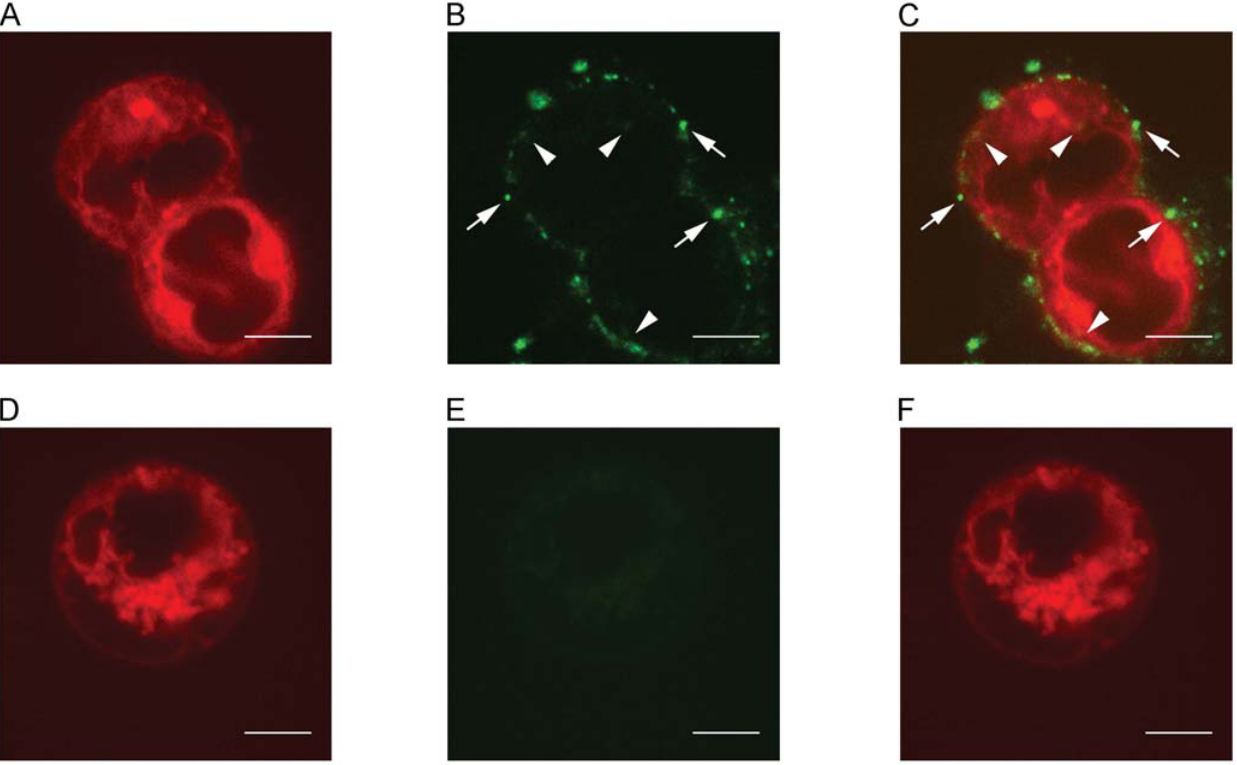
Figure 6. ESMVs transfer GFP. ESCs without the GFP transgene were labeled with DiD and then incubated with ESMVs containing GFP. All confocal images were taken using a 100 6 , 1.4 NA objective with the pinhole set to 1 airy unit. (A) DiD signal from ESCs incubated with ESMVs. (B) GFP signal from ESCs incubated with ESMVs. Arrows indicate punctate signal, likely representing docked vesicles. Arrowheads indicate diffuse signal, likely from the diffusion of GFP inside the cell or from the production of newly translated GFP. (C) Overlay of A + B. (D) DiD signal from control ESCs without ESMVs. (E) No GFP signal can be detected in the absence of ESMVs. (F) Overlay of D + E. All scale bars are 5 m m. doi:10.1371/journal.pone.0004722.g006 polarity is established so that the major axes (i.e. left-right, dorso- ventral, rostro-caudal) can be defined. The development and